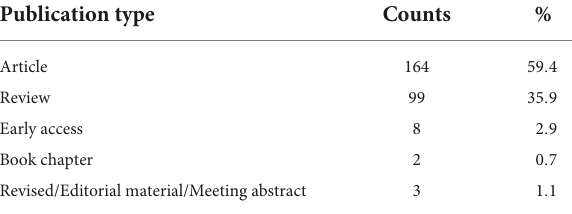
and Japan. Furthermore, the cross-country collaboration also demonstrated that only those dominant countries cooperated, and there was still a wide potential for communication and cooperation in this